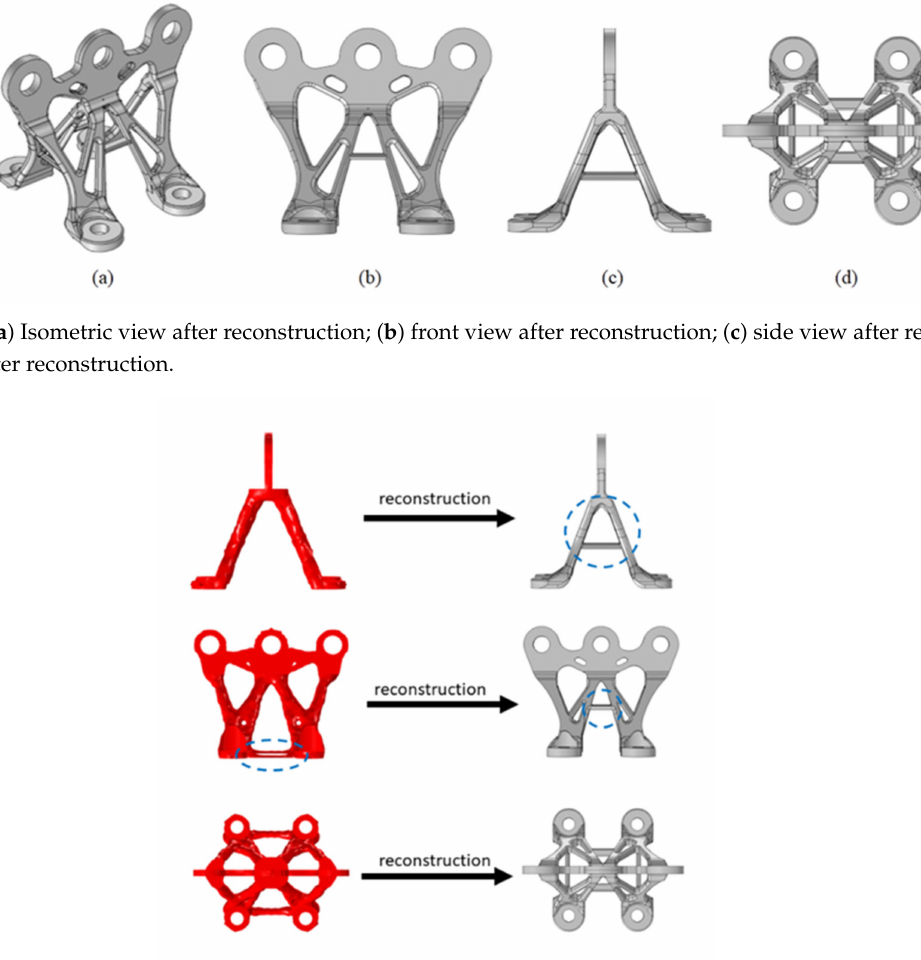
Figure 11. Comparison of topology optimization result and reconstructed geometry.